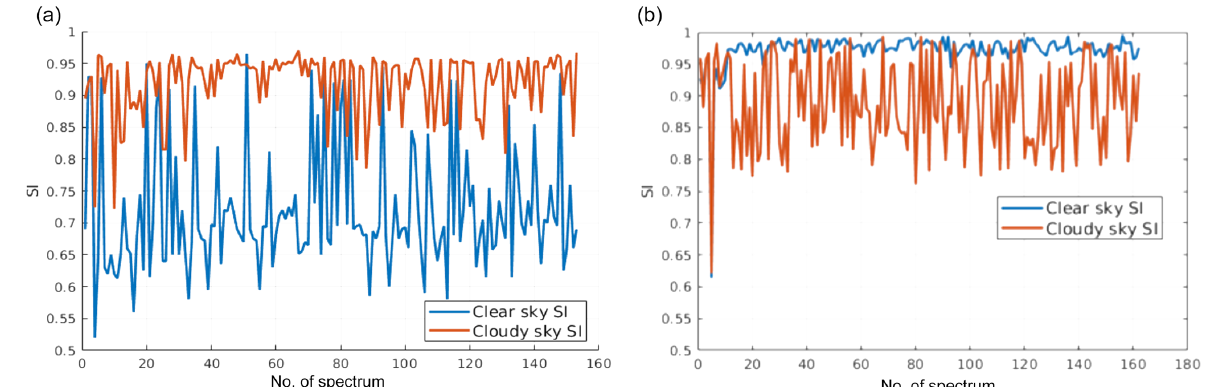
Figure 7. Similarity indices computed using tropical cloudy spectra only (a) or clear-sky spectra only (b) . In orange the SI is computed using the cloudy-sky training set and in blue using the clear-sky training set. The tropical case is accounted for. The full spectrum is used in the SI computations. Details on the training sets are provided below in the text.